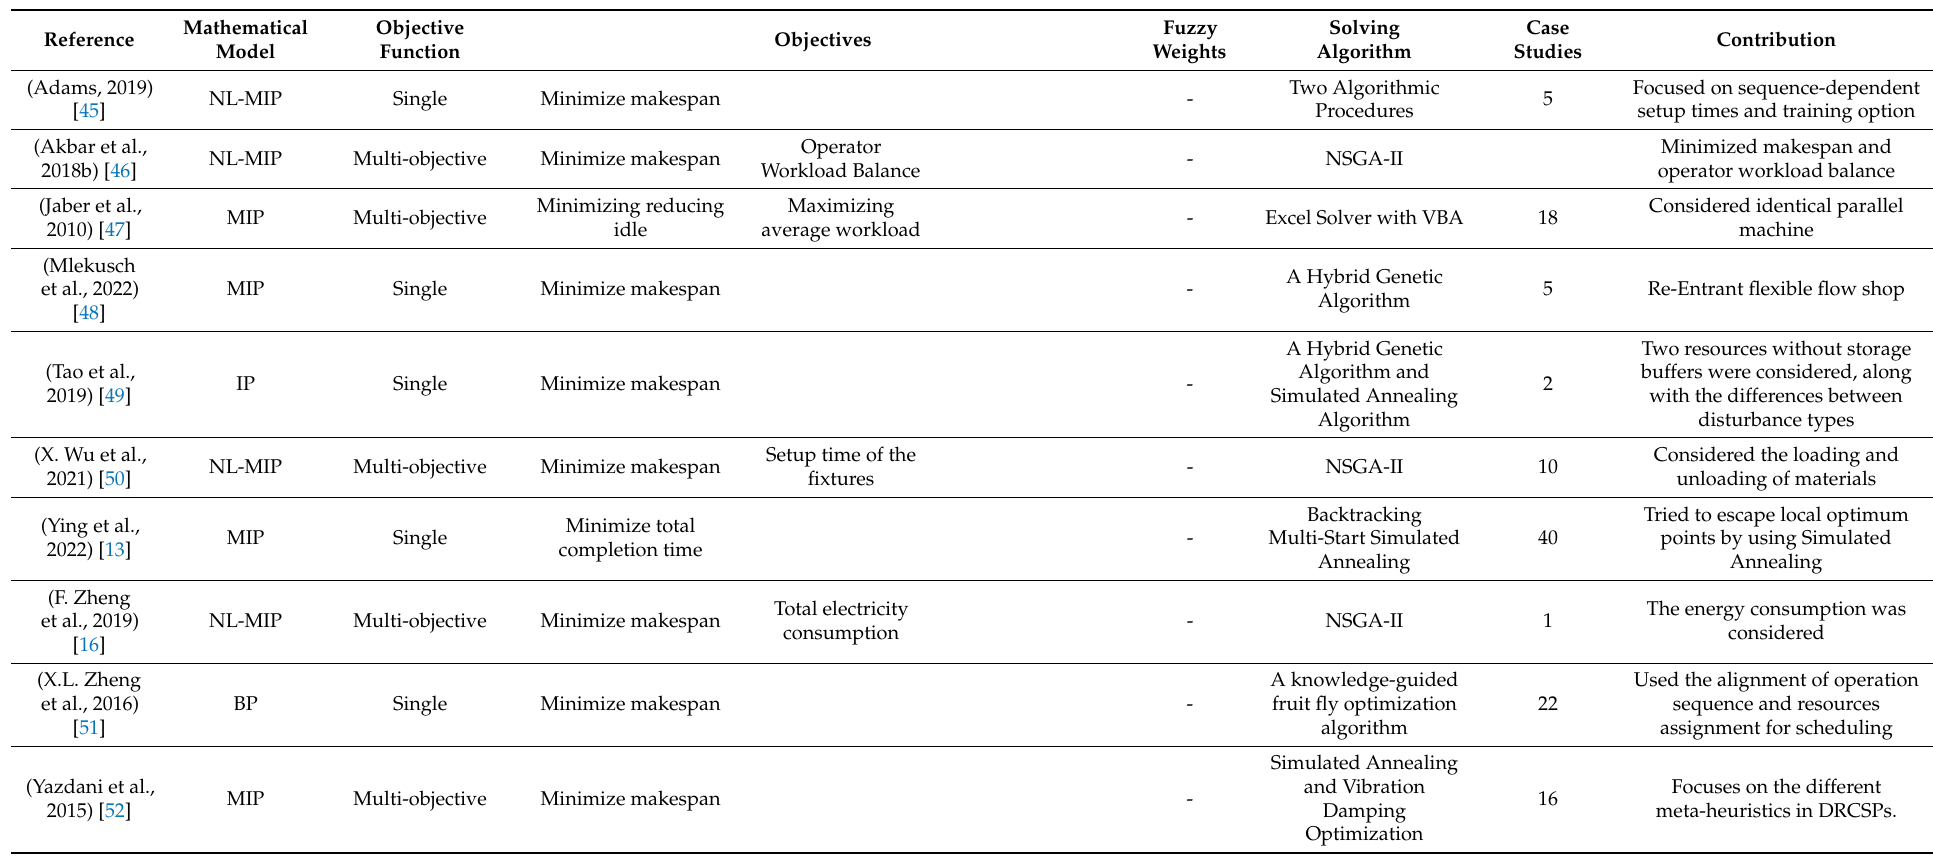
Table 6. Contribution and novelties of this